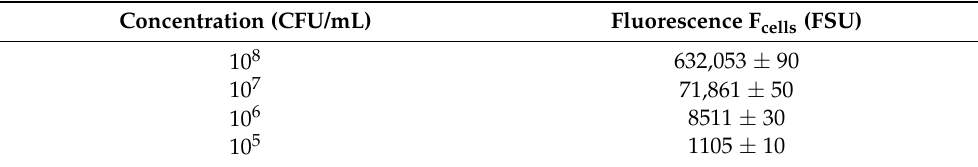
Table 1. Characteristic fluorescence signals of AO-stained suspensions of magnetically tagged bacterial cells of various concentrations (i.e., F cells ).